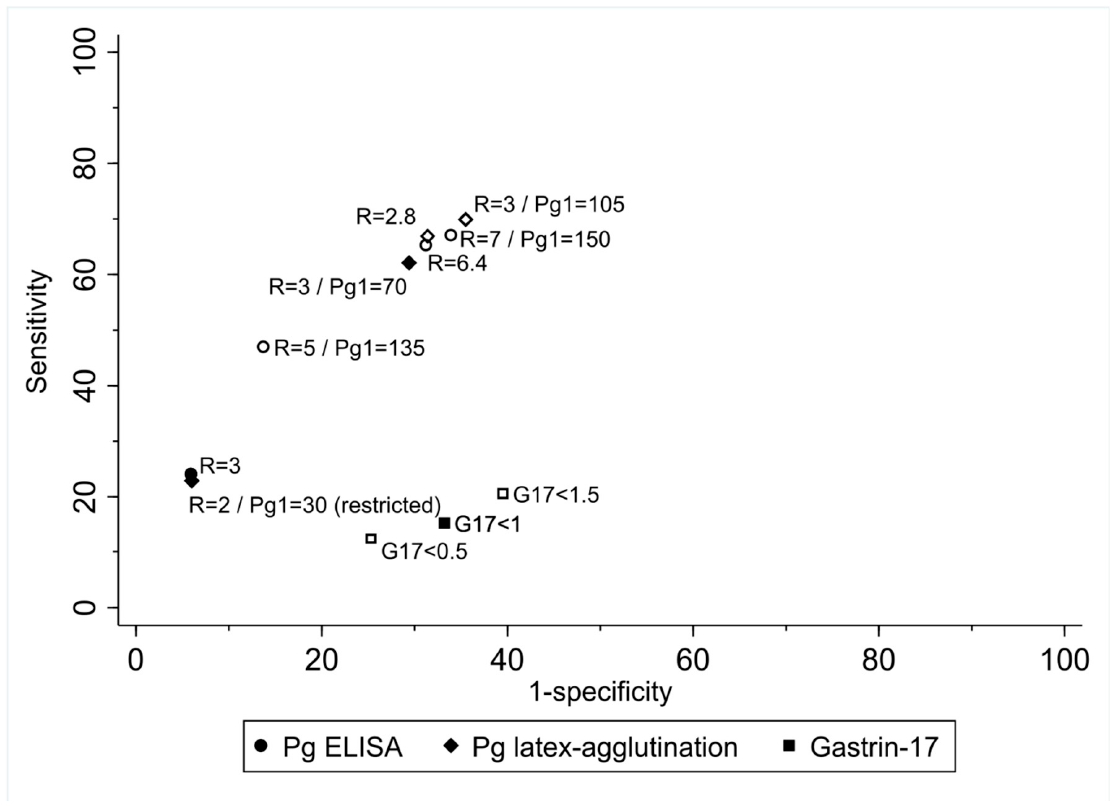
Figure 2. Sensitivity and false positive rate (1-specificity) of ELISA and latex-agglutination pepsino- gens tests and gastrin-17 test to detect a combined outcome including corpus atrophy, intestinal metaplasia or worse at standard (solid markers) and best alternative cut-offs with highest ROC area, value closest-to-(0,1) corner in the ROC curve and highest values using the Liu method and Youden Index (blank markers). Abbreviations: Pg = Pepsinogen, R = ratio. Numbers provided are corrected for verification bias using the Begg and Greenes method.